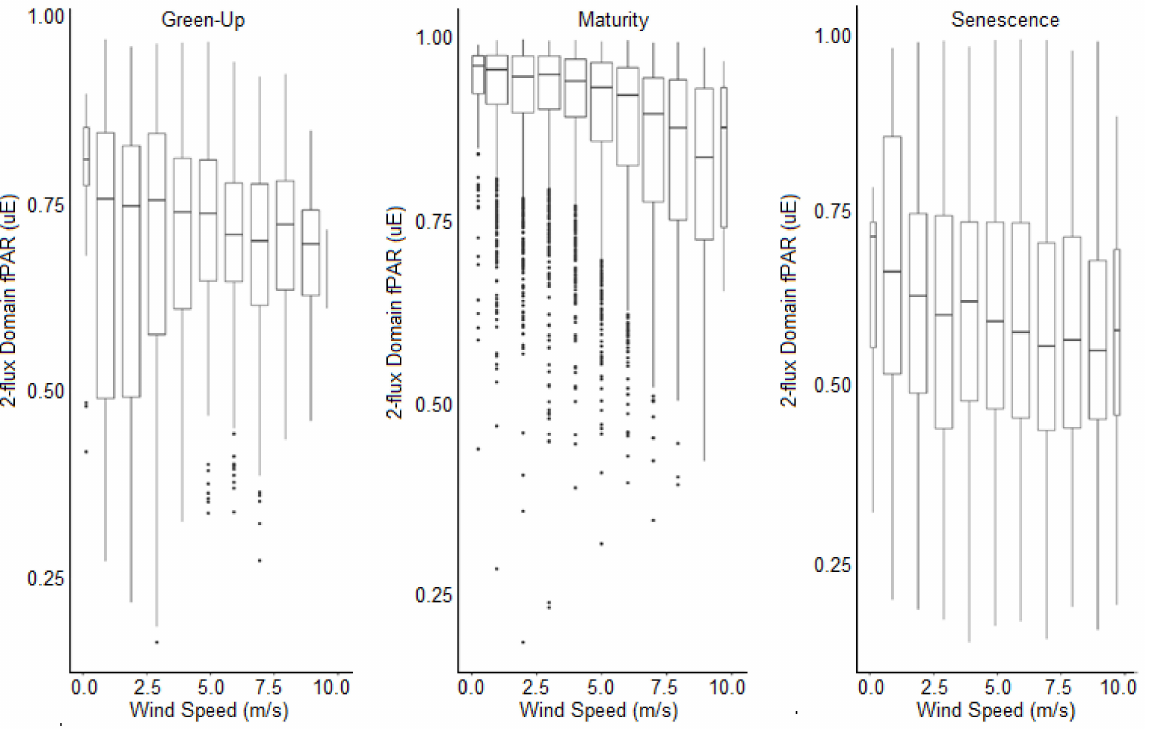
Figure 7. The influence of wind speed on the estimation of 2-flux fPAR Domain by phenophase: ( left ) green-up; ( center ) maturity; ( right ) senescence. Boxplots represent the IQR of each set of measurements, while wind speed is broken into 1ms − 1 groupings for the